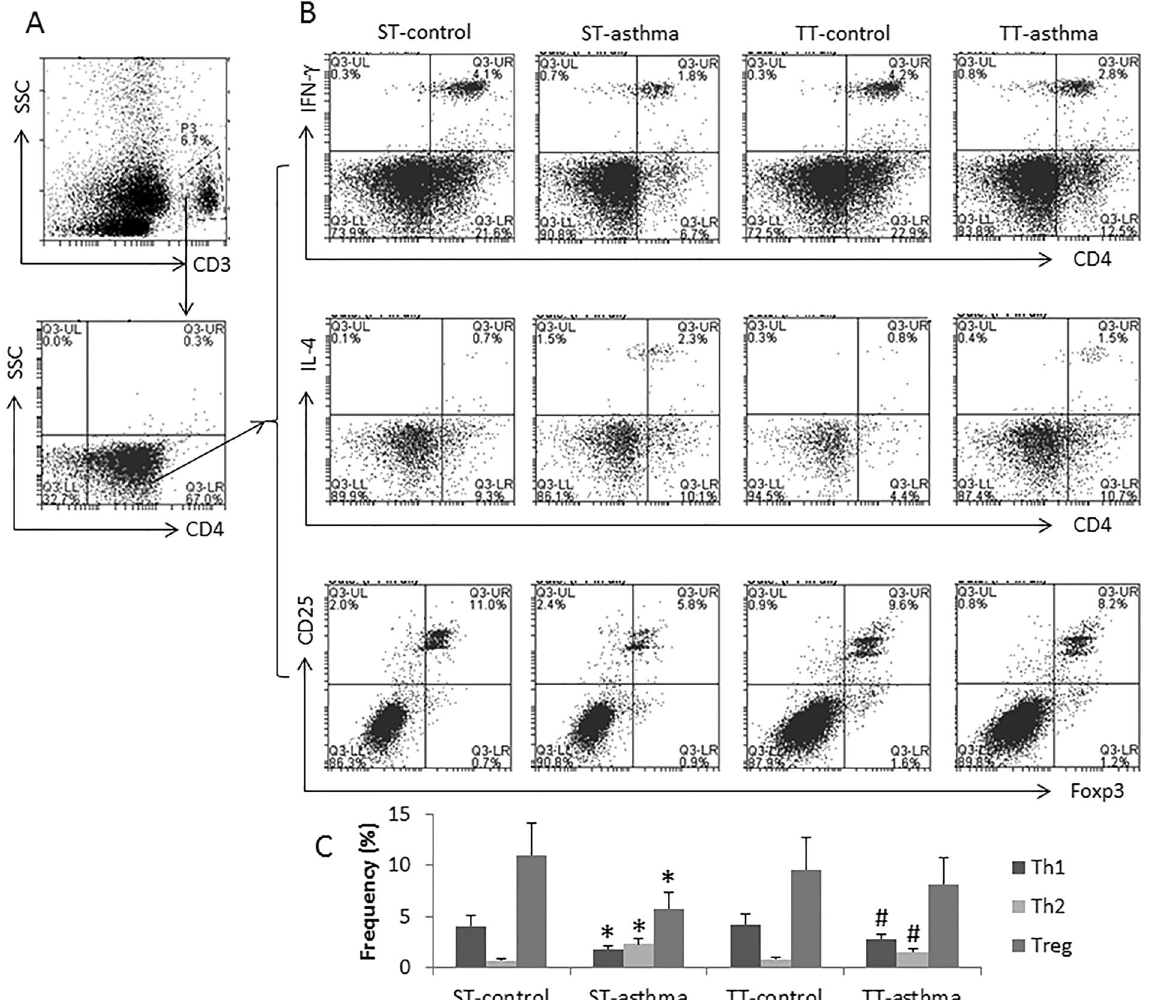
Figure 3. Effects of changing ambient temperature on Th1/Th2 cell and Treg cell populations in the spleen. Spleen cells were prepared from each mouse after treating with ST or TT. The cells were analyzed by flow cytometry. ( A ) The dot plots show the CD3 + and CD4 + T cells were gated. ( B ) The dot plots show the frequency of IFN- γ + , IL-4 + and IL-13 + cells, respectively, in the gated CD4 + T cells of panel A. C, the bars show the summarized data of panel B. The data of bars are presented as mean ± SEM. * p < 0.05 (t test), compared to the ST-control group. #p < 0.05, compared to the TT-control group. Each group consists of 6